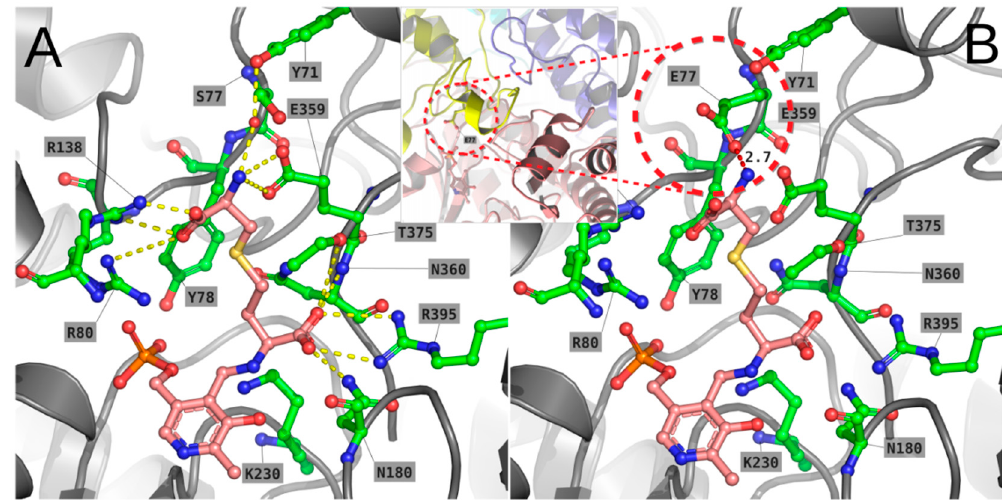
Figure 8. Modelling of the external aldimine of wild type ( A ) and the S77E mutant ( B ) of TgCGL in complex with L -cth. The external aldimines are shown as pink sticks. Residues described in text are labelled in single-letter code. Potential favourable and unfavourable interactions are depicted as yellow ( A ) and red ( B ) dashes, respectively. The position of the loop hosting E77 relatively to the other chains (A = yellow; B = pink; C = cyan; D = blue) of the quaternary structure is shown in the inset of panel ( B ).